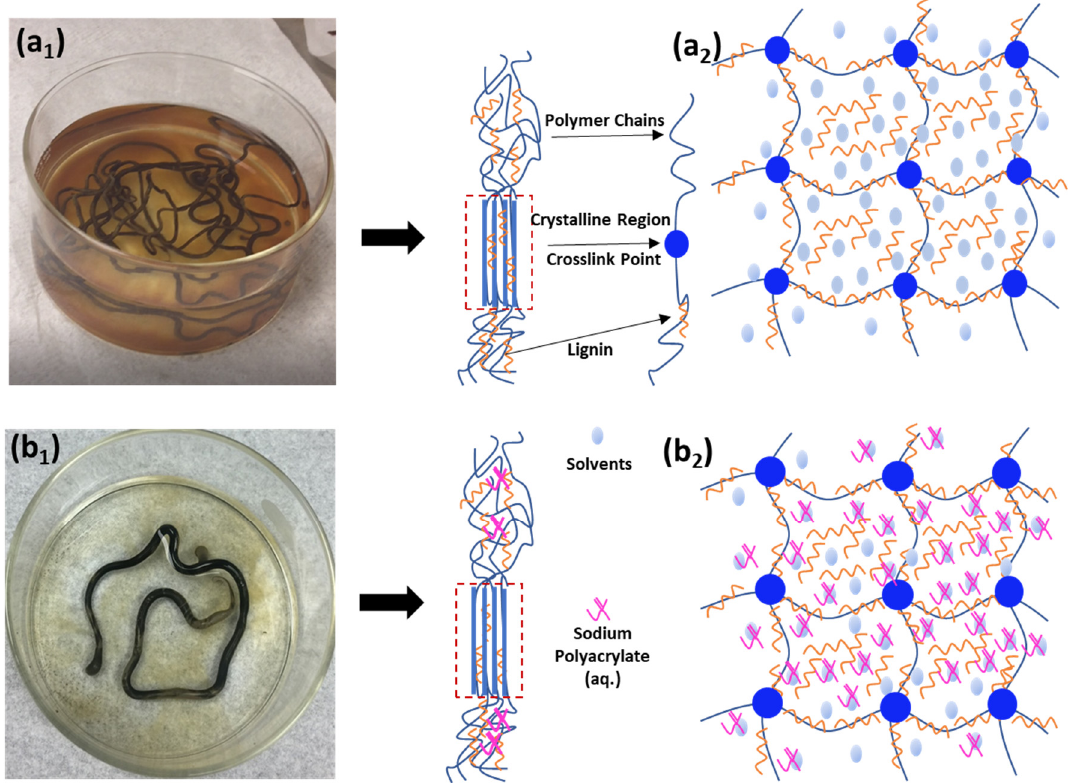
Figure 3. Illustration of fiber microstructures of Lignin/PVA 1:1 ( w/w ) fibers ( a ) without SPA additive and ( b ) with SPA additive at 50% lignin content in (1) digital photographs of coagulation test and (2) fiber microstructures.